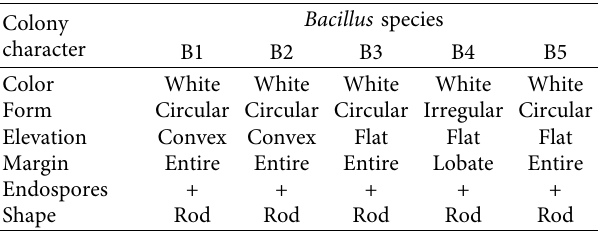
Table 1: The morphological and microscopic results of the isolated Bacillus colony. Colony